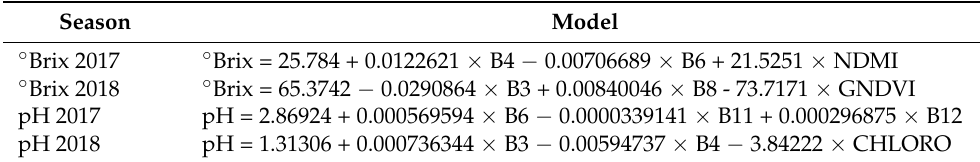
Table 7. Equations for modeling ◦ Brix and pH in seasons 2017 and 2018.